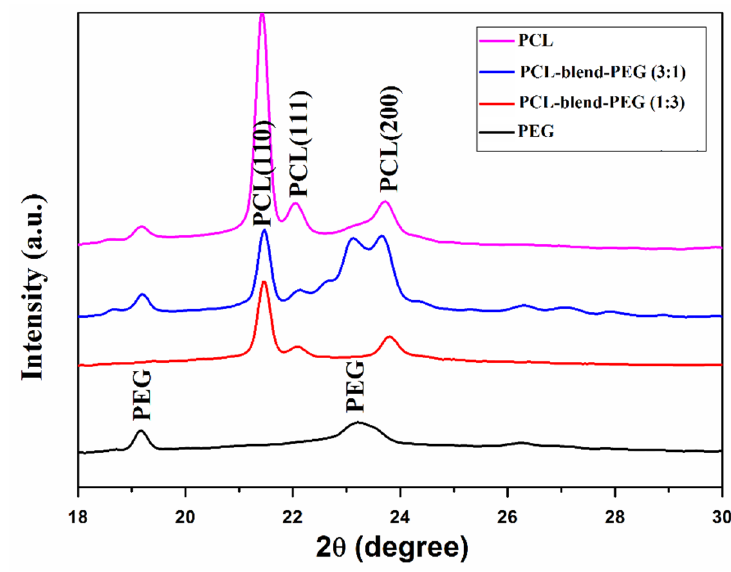
Figure 4. XRD diffractograms of dip-coated films: PCL (pink); PEG (black); PCL-blend-PEG (1:3) (red); PCL-blend-PEG (3:1) (blue).